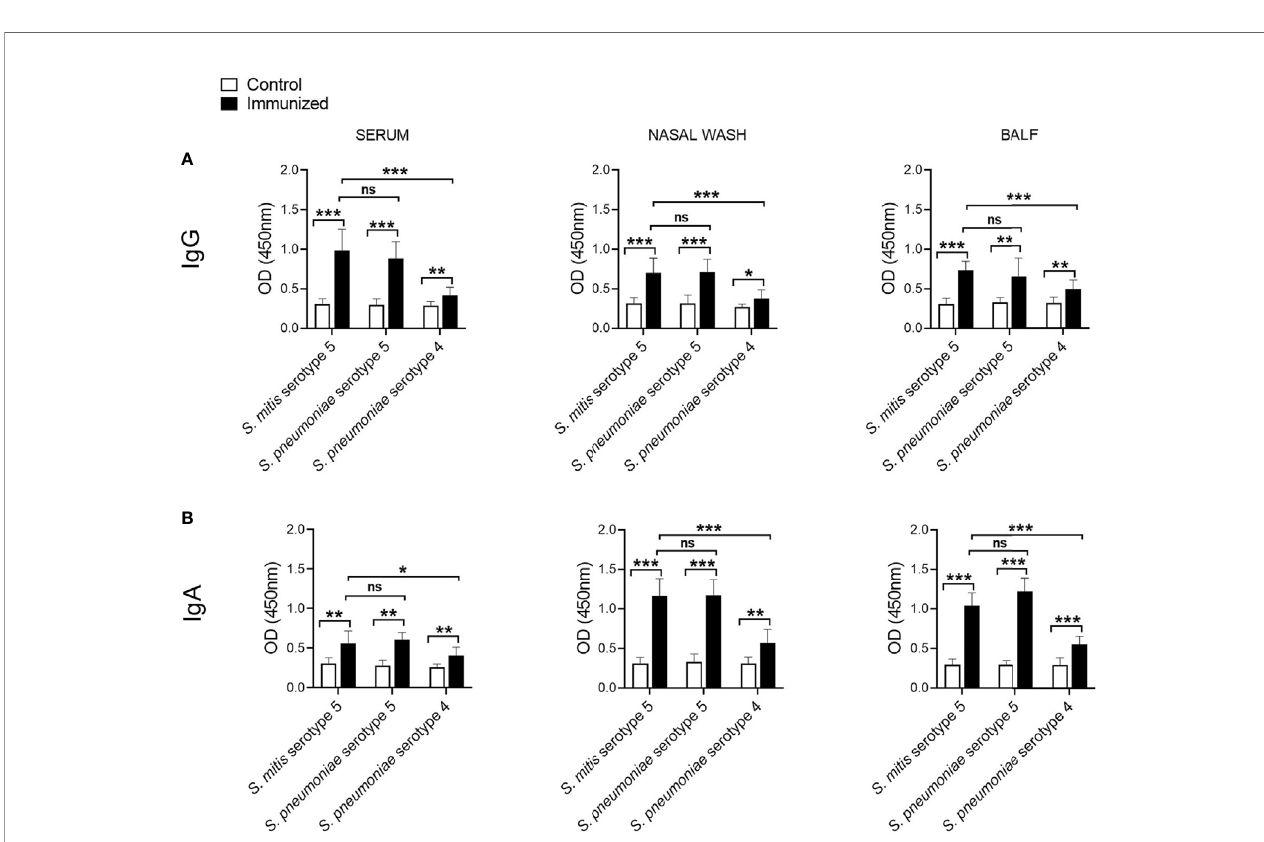
FIGURE 2 | IgG and IgA responses to S . pneumoniae following immunization with S. mitis serotype 5. Mice were immunized with S. mitis , which was followed by pneumococcal lung infection, and the nasal wash, BALF and sera samples were collected to analyze (A) IgG and (B) IgA responses. Levels of IgG and IgA antibodies reactive to pneumococcal serotypes in the sera were measured by whole cell ELISA. The sera were diluted 1:1000, and the nasal wash and BALF 1:10. Data are shown as mean ± SD and pooled from the results of two independent experiments with 4 mice in each group. *p<0.05; **p<0.01; ***p<0.001. Unpaired student ’ s t test. ns, not signi fi